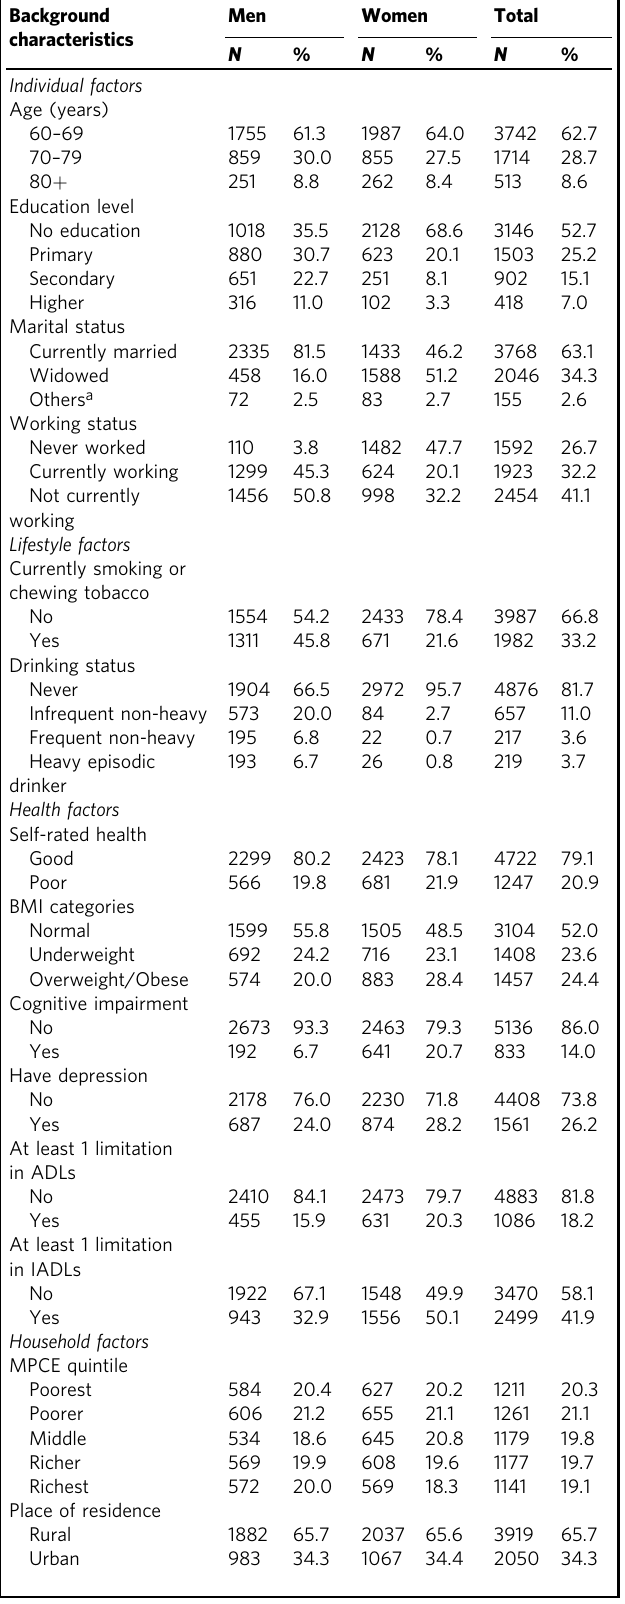
Table 1 Socio-economic and demographic characteristics of the older adults, by gender, ( N = 5969), LASI, 2017 – 18. Background